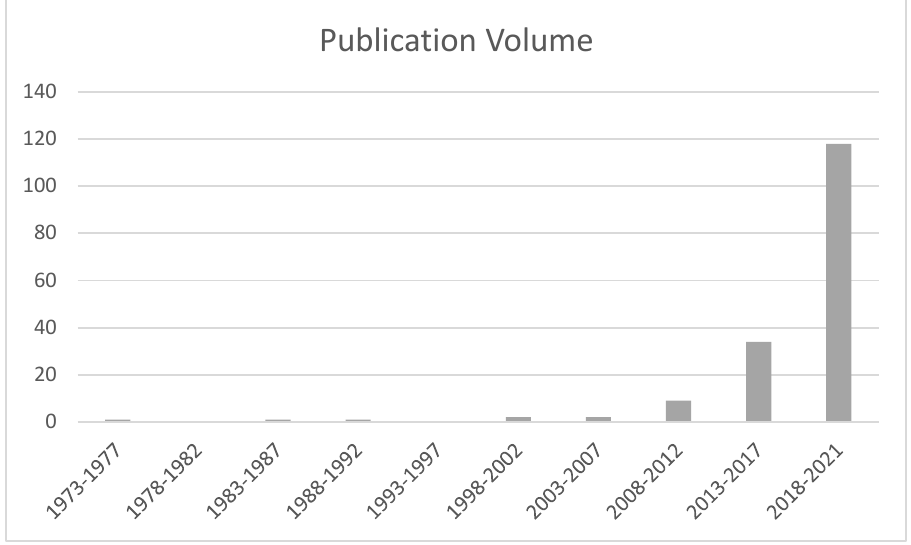
Figure 2. Trend of Publication Volume by Five-Year Interval during 1973 – 2021 (N = 168).